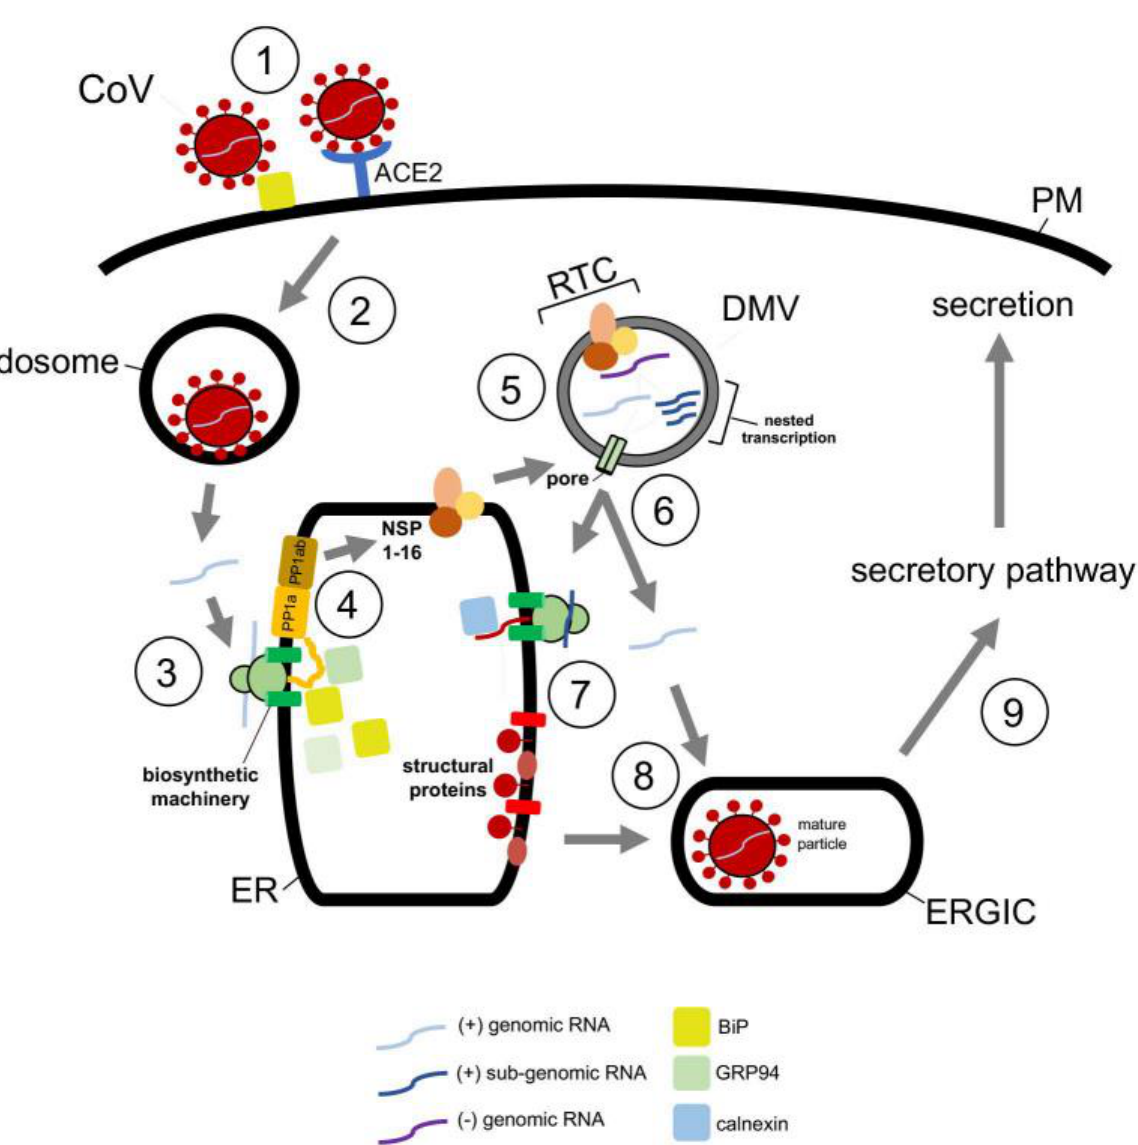
Figure 4. Repurposing ER-associated chaperones during coronavirus entry. Coronavirus CoV entry pathway (see text for more details). Initial attachment to the plasma membrane and subsequent receptor binding to the viral particle at the cell surface is facilitated by the ER luminal BiP chaperone (step 1) . The virus then undergoes endocytosis to reach the endosome (step 2). Here fusion between the viral and endosomal membranes results in release of the viral genome into the cytosol. The cytosol-localized genomic RNA is then cotranslationally translocated on the ER membrane (step 3) , generating the viral PP1a and PP1ab polypeptides (step 4) ; in this step, the ER-resident chaperones BiP and GRP94 are thought to facilitate proper protein folding. The polyproteins are proteolytically cleaved, forming NSP1-16. Some of these nonstructural proteins (NSPs) assist in formation of the double-membrane vesicle (DMV). Within the DMV, the replicase and transcriptase complex (RTC) is formed (step 5) . At this site, viral genome replication occurs, producing many copies of the full-length RNA genome. Additionally, subgenomic RNAs are generated via nested transcription. The full-length and subgenomic RNAs are released from the DMV (step 6) . Those subgenomic RNAs encoding M, S, and E are delivered to the ER where these structural proteins are synthesized (step 7) ; in this process, the ER luminal calnexin chaperone assists in proper folding of the viral proteins. By contrast, the subgenomic RNA encoding N is translated in the cytosol to form the N protein which complexes with the newly-synthesized viral full-length genomic RNA. The M, S, and E structural proteins exit the ER and transport to the ERGIC for packaging with the N protein-genomic RNA complex (step 8) . Finally, the mature viral particle is formed and trafficked along the secretory pathway for secretion (step 9) .